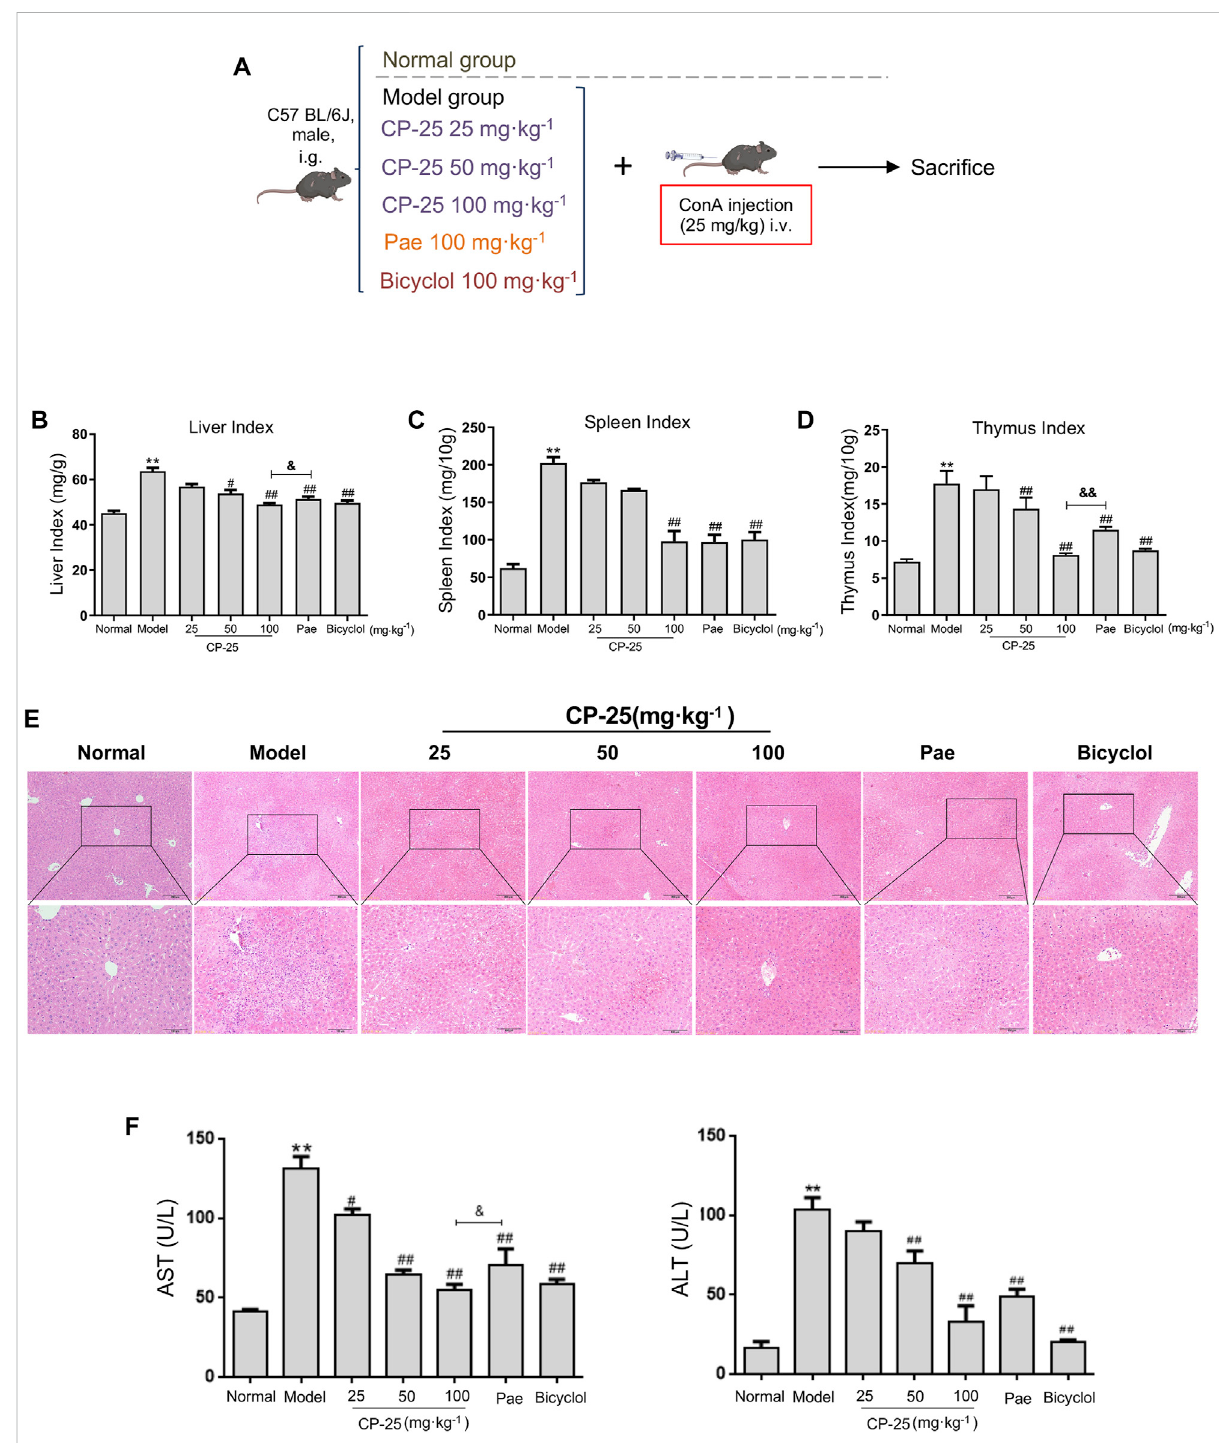
FIGURE 1 CP-25 attenuated ConA induced hepatitis. (A) ConA-induced hepatitis model and pretreatment of drugs. (B) Liver index. (C) Spleen index. (D) Thymus index. (E) The photomicrographs are of representative H&E-stained liver tissues after ConA injection of mice. (F) The serum AST and ALT activities. Data were representative as the means ± SD. **p < 0.01 versus normal, # p < 0.05, ## p < 0.01 versus model, & p < 0.05, && p < 0.01 versus paeoni fl